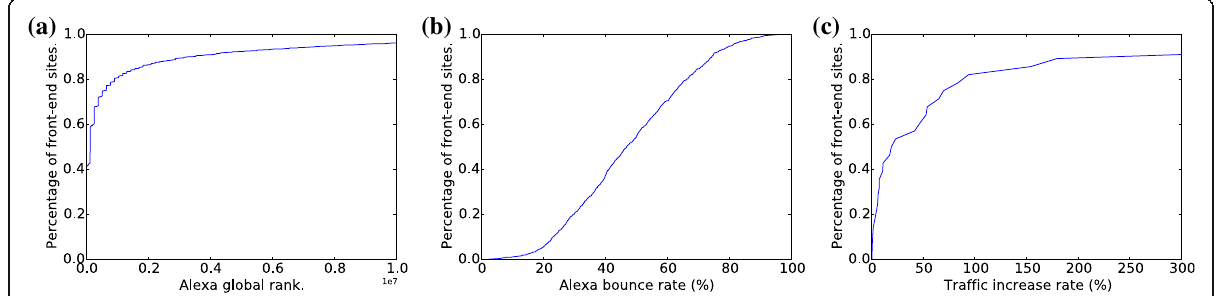
Fig. 9 Alexa global rank, bounce rate and traffic increase rate of Bar ’ s front-end websites. a Cumulative distribution of Alexa global ranks per Bar ’ s front-end sites. b Cumulative distribution of Alexa global ranks per Bars ’ Alexa bounce rate. c Cumulative distribution of Bar ’ s traffic increase rate per Bar ’ s front-end